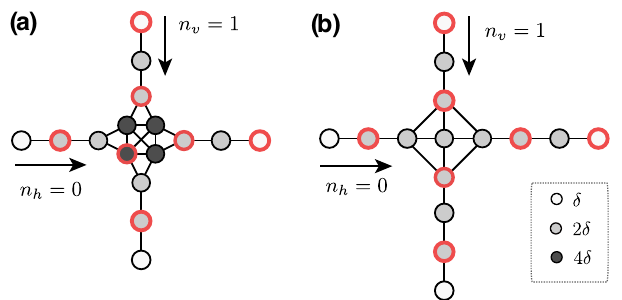
FIG. 5. (a) Two decoupled effective degrees of freedom. By combining the copy gadget and the crossing gadget, we can form two 1D lines, here drawn horizontally and vertically. Both lines represent a binary variable, n h ∈ { 0, 1 } and n v ∈ { 0, 1 } , respec- tively. The crossing gadget effectively decouples these degrees of freedom. Accordingly, this weighted graph has a fourfold degen- erate MWIS, corresponding to the four possible states of two binary variables. One of the MWISs is shown in red correspond- ing to n h = 0 and n v = 1. Note that each of the four MWISs contains exactly one of the four internal vertices of the cross- ing gadget, so these internal vertices encode the states of both effective degrees of freedom. (b) Two effective degrees of free- dom, defined on a horizontal and a vertical line, respectively, that satisfy an independence constraint n h n v = 0,